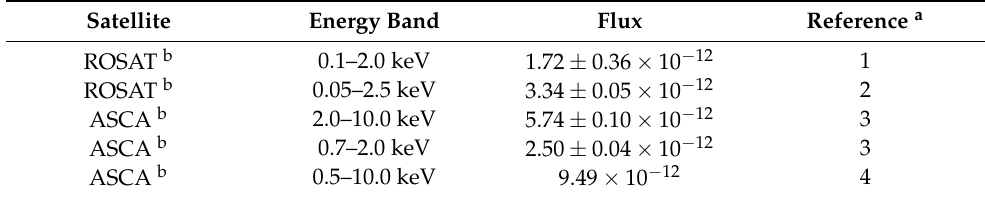
Table 1. Quasi-simultaneous multi-band flux during EGRET time.